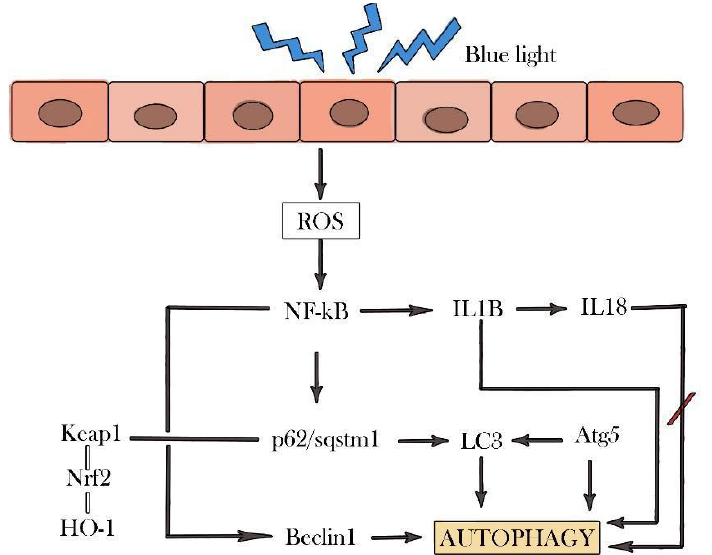
Figure 1. Autophagy activation pathways. Blue light increases ROS production in RPE cells, activating NF-kB, which modulates autophagy, antioxidant, and inflammatory pathways.